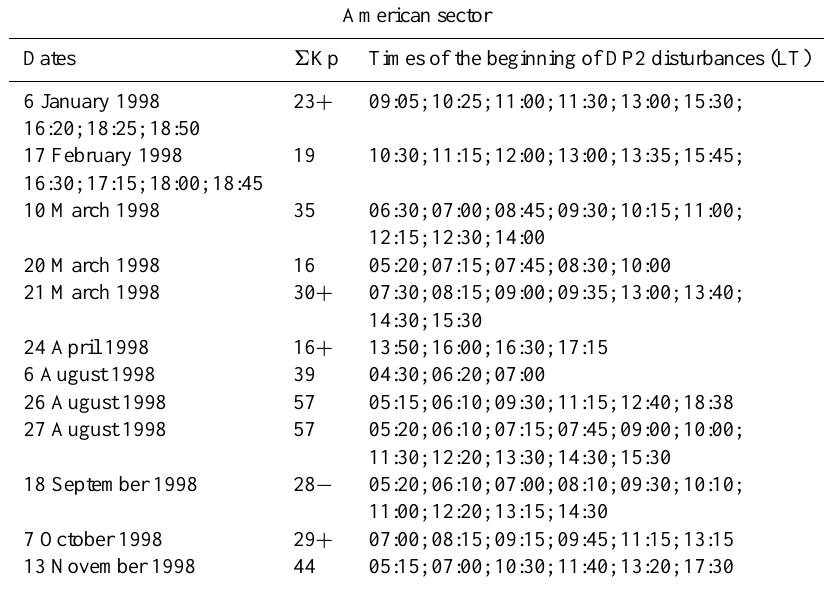
Table 3c. Magnetic storms days selected of 1998 and times of the beginning of DP2 disturbances at Yap (YAP) over Asian sector.